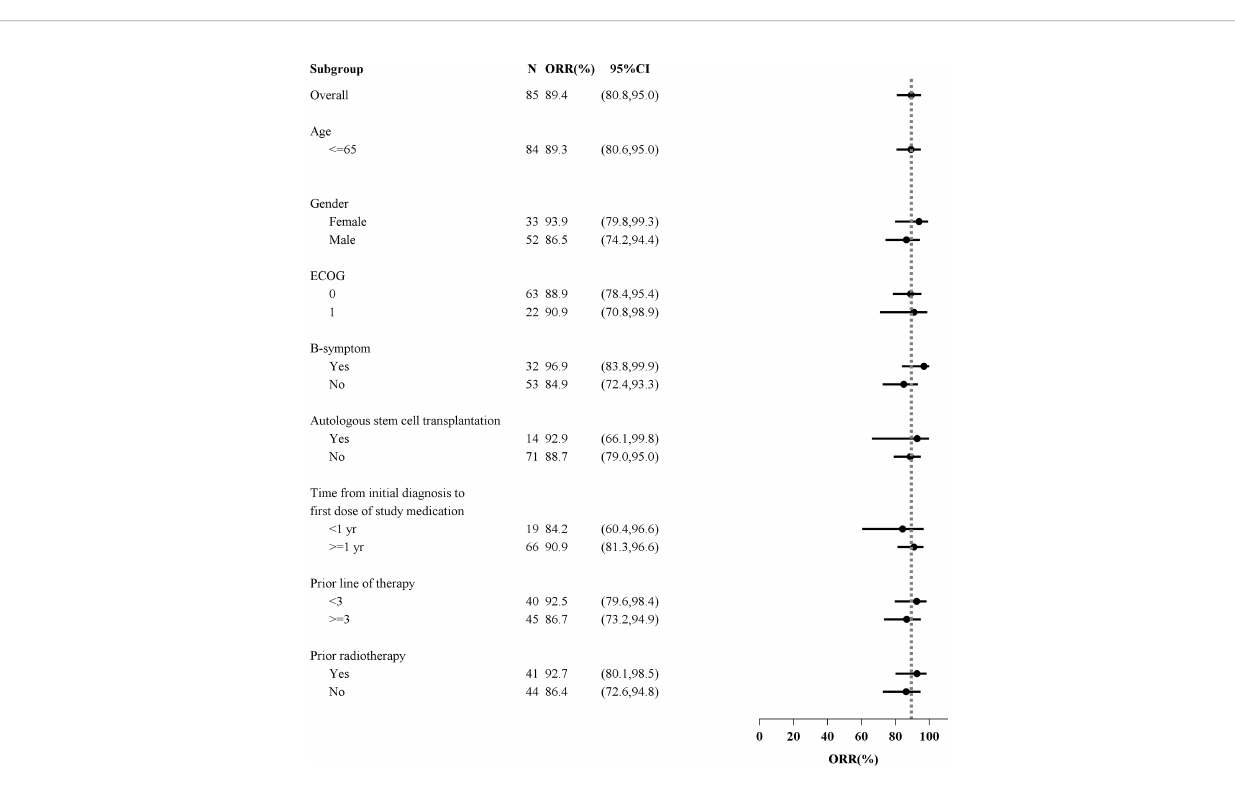
FIGURE 3 | Forest plot analysis of objective response rate (ORR) by patient